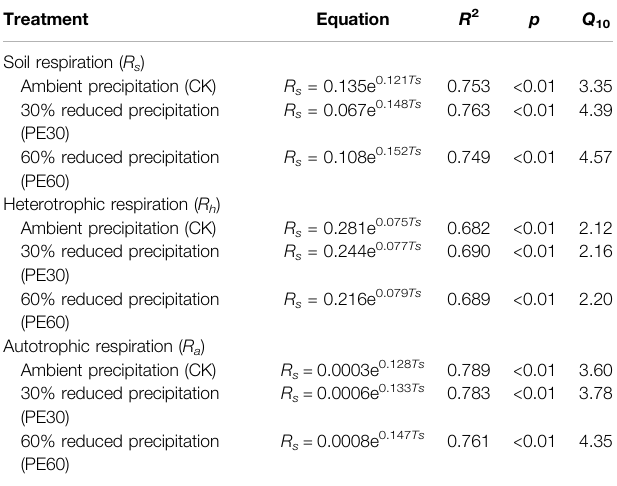
TABLE 1 | Impacts of soil temperature ( T s , ° C) on the variation of different soil respiration components ( R , μ mol m − 2 s − 1 ). R 2 , p ,and Q 10 valuesarereported. Treatment Equation R